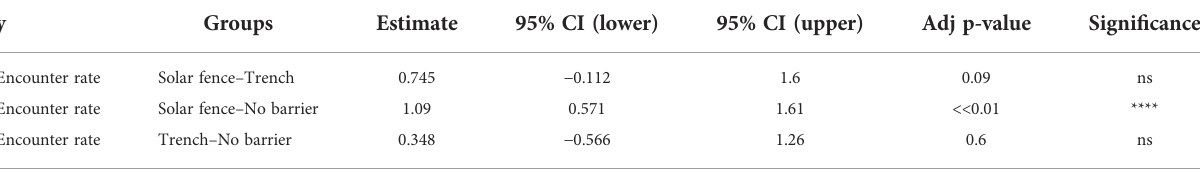
Encounter rate Solar fence – Trench Encounter rate Encounter